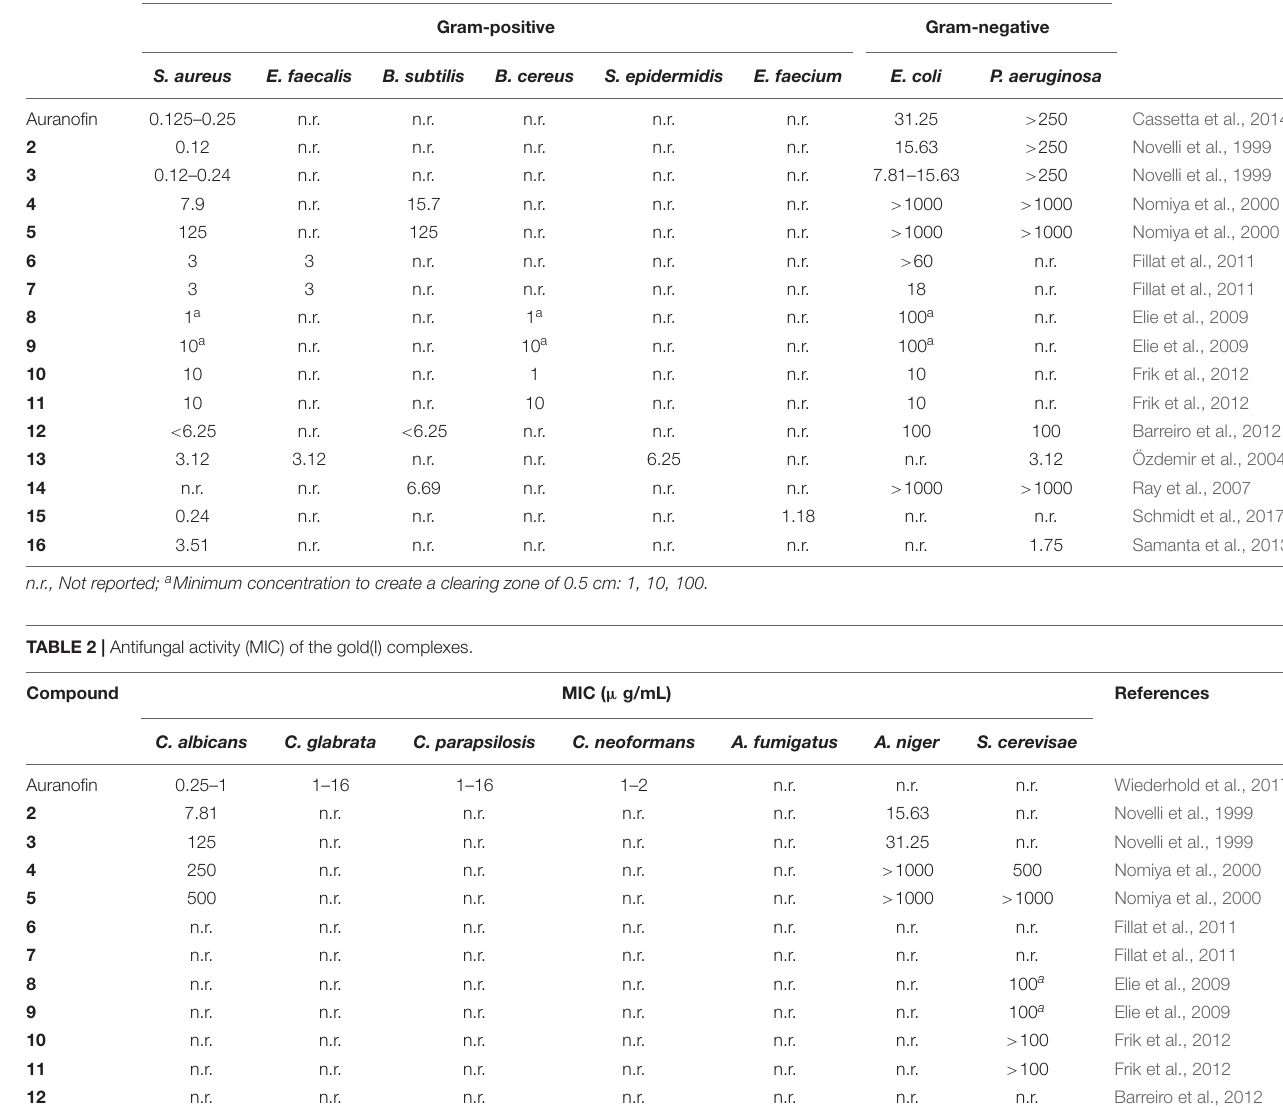
TABLE 1 | Antibacterial activity (MIC) of the gold(I) complexes. Compound